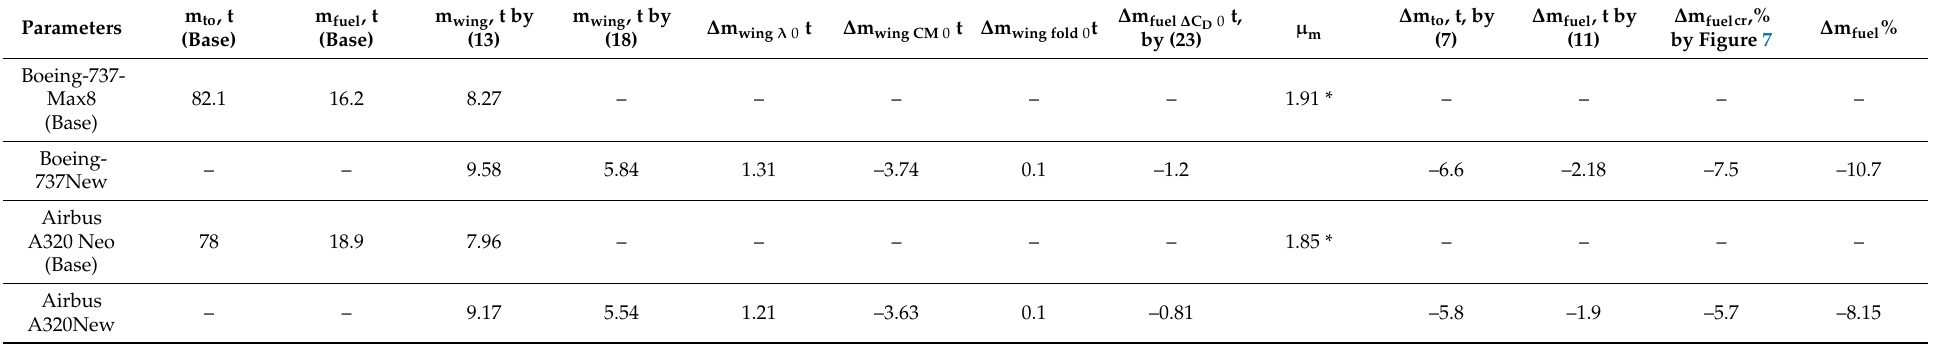
Table 3. Characteristics of masses for Boeing 737Max 8 and Airbus A320Neo and theirnew